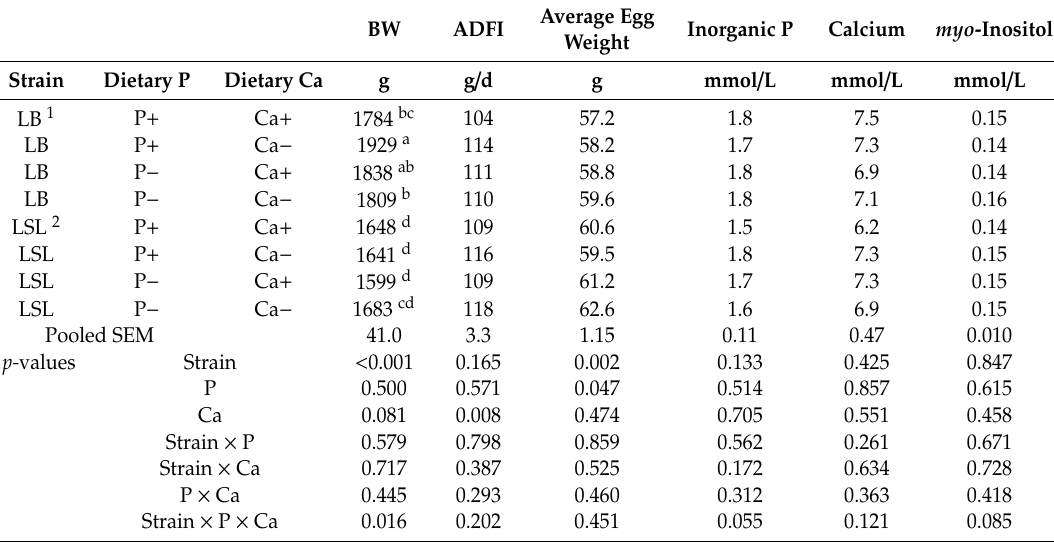
Table 2. E ff ect of hen strain, P, and Ca on body weight (BW); average daily feed intake (ADFI); average egg weight in the excreta collection period; and concentrations of inorganic P, Ca, and myo -inositol in the blood plasma of laying hens aged 31 weeks. Average Egg Inorganic P Calcium myo -Inositol BW ADFI Weight Strain Dietary P Dietary Ca g g / d g mmol / L mmol / L